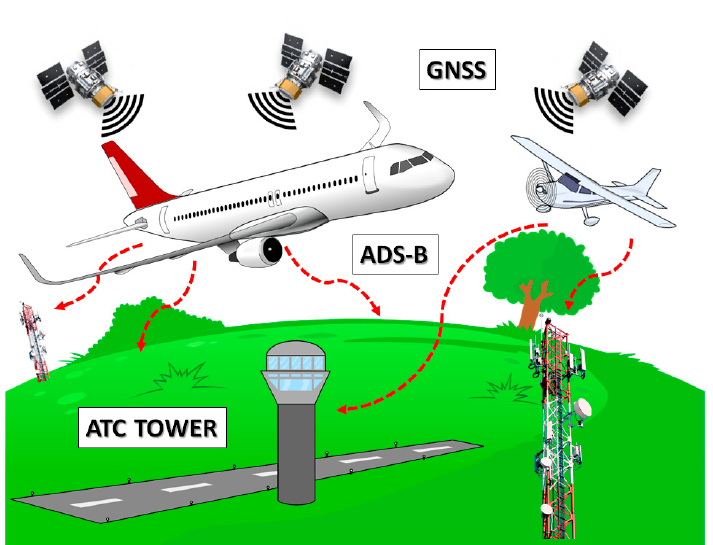
Figure 1. ADS-B layout, showing aircraft receiving GNSS signal and transmitting ADS-B signals (red dashed arrows) to ATC and receiving ground stations on high masts.